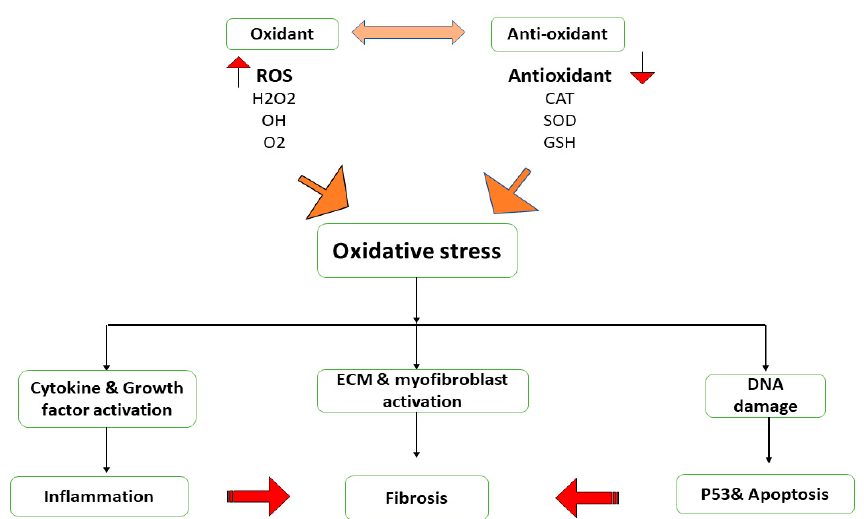
Figure 7. In the pathogenesis of fibrosis, oxidative stress plays a crucial role by promoting inflam- mation by increasing the production of cytokines and growth factors, increasing myofibroblast differentiation and fibrogenesis, and as a result of DNA damage and p53 activation, ROS promotes apoptosis. These changes aid in the development of fibrosis. CAT; catalase, SOD; superoxide dismu-